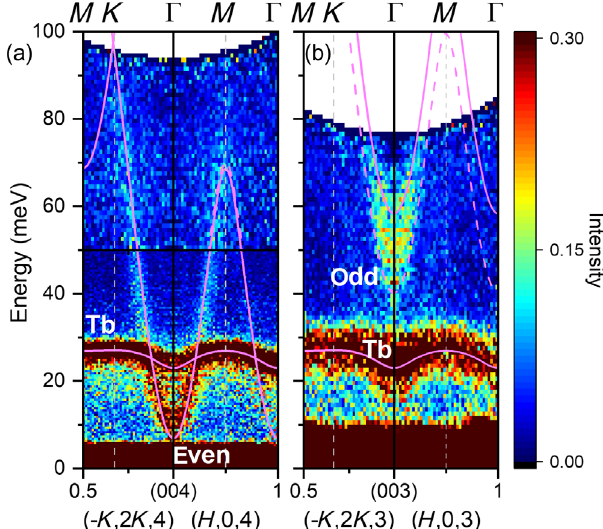
FIG. 6. (a) Slices of the data highlighting the dispersion of the even mode along the ð H; 0 ; 0 Þ and ð − K; 2 K; 0 Þ directions in the (0,0,4) zone with E i ¼ 160 meV (lower panel) and E i ¼ 250 meV (upper panel). (b) Slices of the data highlighting the dispersion of the odd mode along the ð H; 0 ; 0 Þ and ð − K; 2 K; 0 Þ directions in the (0,0,3) zone with E i ¼ 160 meV. For (a) and (b), the data are averaged over Δ L ¼ (cid:4) 0 . 5 and either Δ H ¼ (cid:4) 0 . 1 or Δ K ¼ (cid:4) 0 . 058 . In all panels, pink lines correspond to model dispersions with L ¼ 0 (solid lines) and L ¼ 0 . 5 (dashed lines).